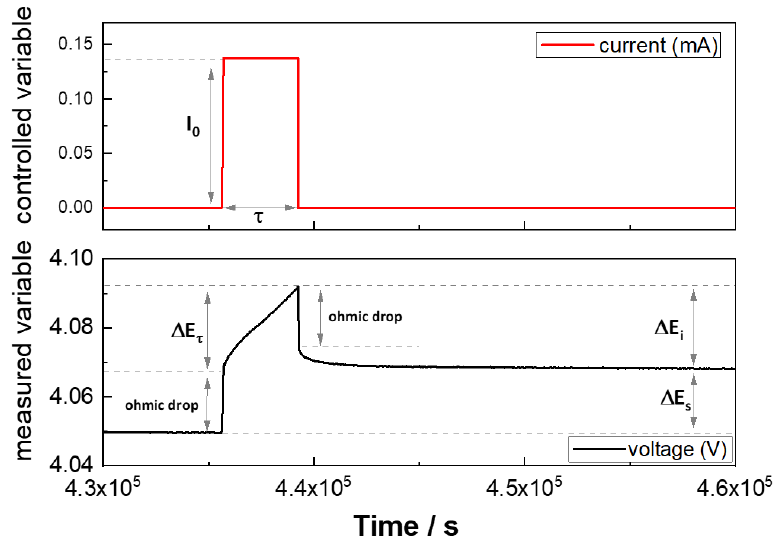
Figure 1. Example of a constant current pulse applied for a known interval of time τ , followed by a relaxation time, while measuring the corresponding potential.